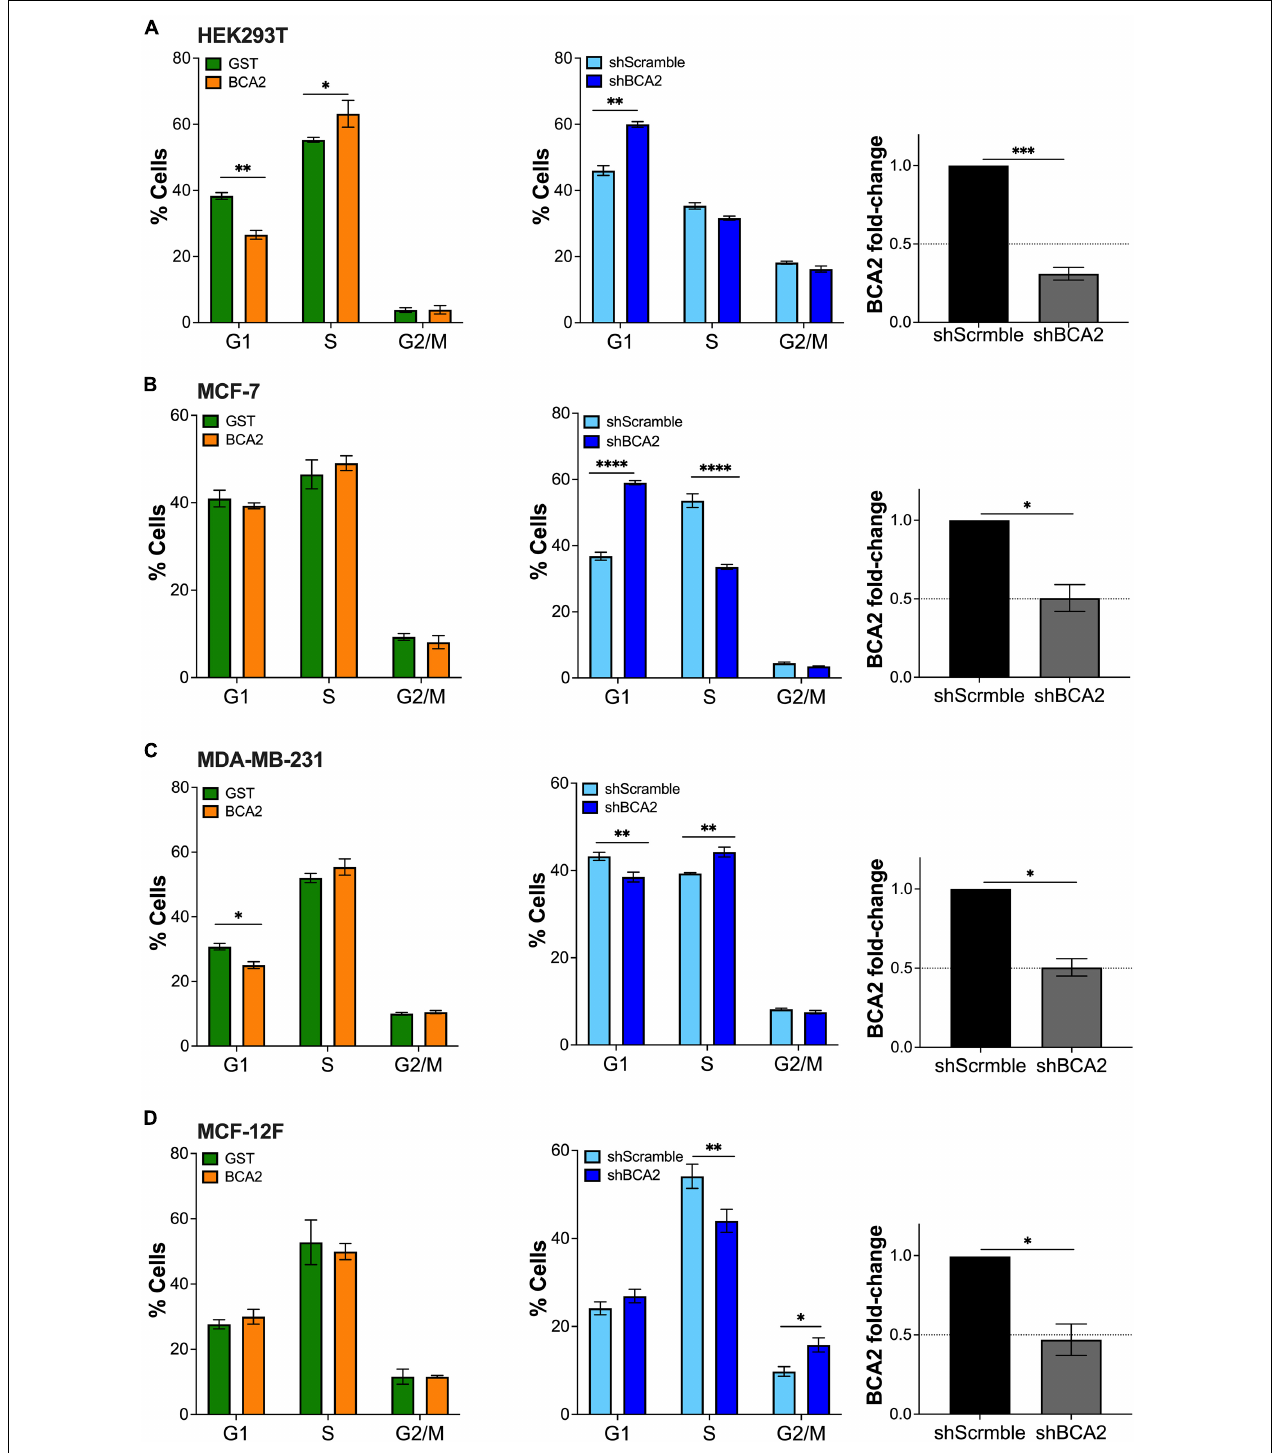
FIGURE 4 | Up-regulation of BCA2 increases the transition from G1 to S phase. Cells, including HEK293T cells (A) , MCF-7 (B) , MDA-MB-231 (C) , and MCF-12F (D) were transfected with constructs encoding for HA-BCA2 or HA-GST as an irrelevant protein control. The abundance of cells in each phase of cell cycle was measured at the peak of HA-BCA2 expression (48 h post-transfection) by flow cytometry, after gating on the HA + population (left panels). Similar assays were performed in cells stably depleted of BCA2 or carrying a scrambled shRNA (middle panels). BCA2 knockdown was verified on the day of analysis by RT-qPCR (right panels). Dotted lines represent threshold for biological significance. Data correspond to the mean and SEM of three independent experiments. * p < 0.05, ** p < 0.01, *** p < 0.001, **** p < 0.0001.